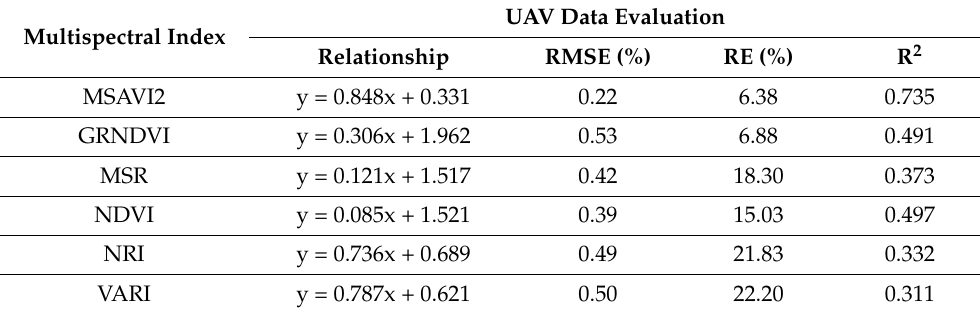
Table 5. Evaluation results of nitrogen in summer maize in the VT to R6